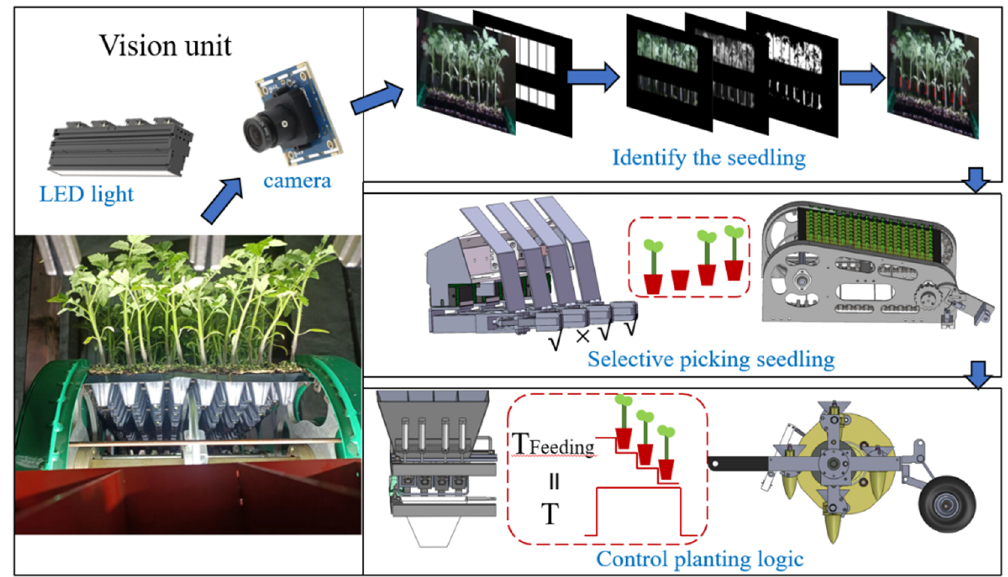
Figure 5. Illustration of Seedling Selective Planting System.